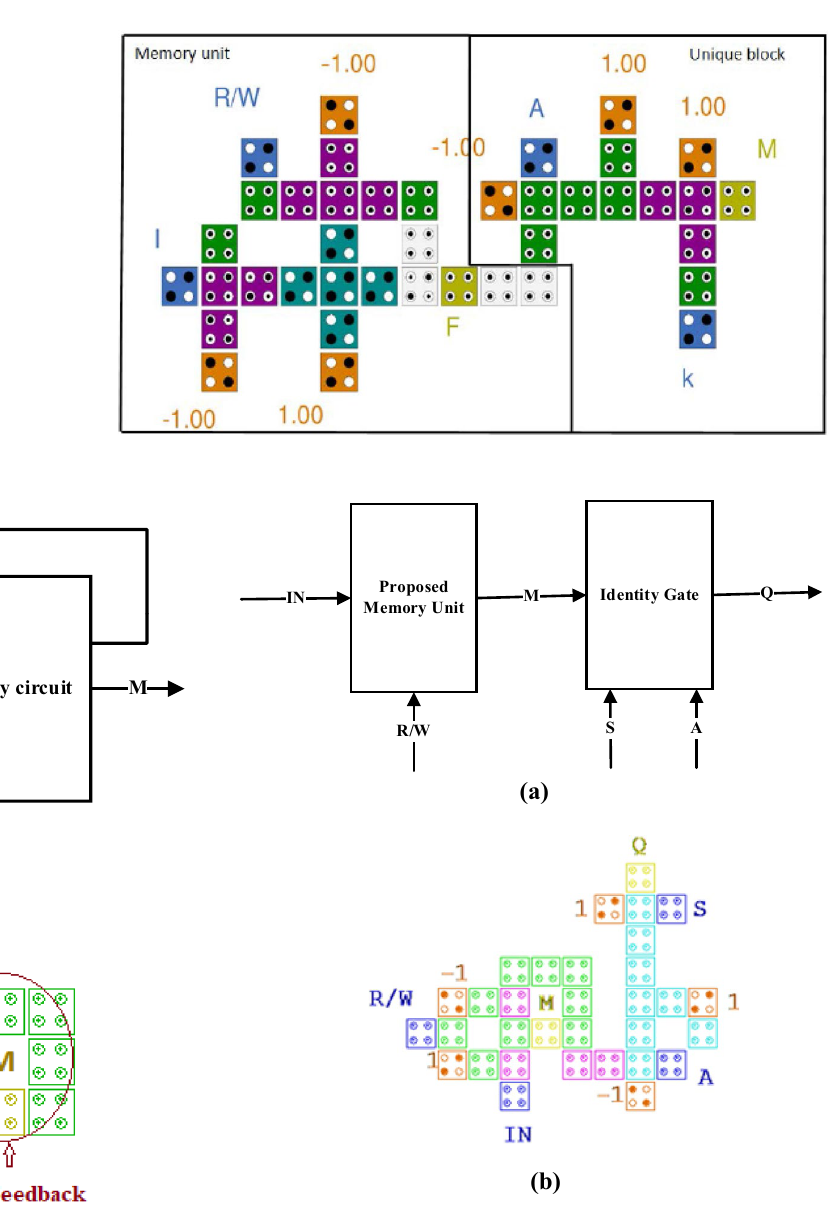
Fig. 14 The proposed CAM circuit; a block diagram and b imple- mentation in the QCA